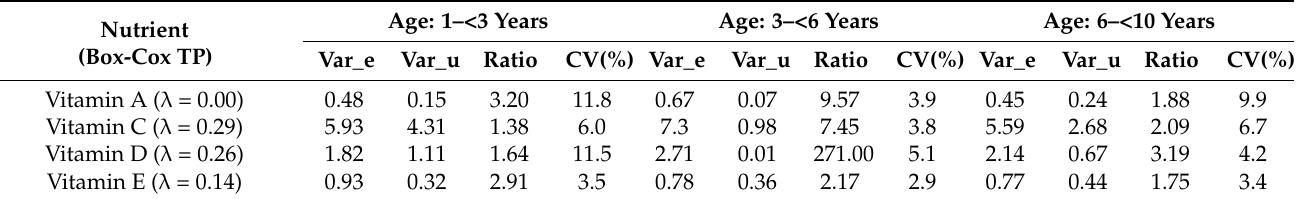
Table 6. The relationship between within-person and between-person variance for vitamins A, C, D and E as well as the CV for usual intake, by age